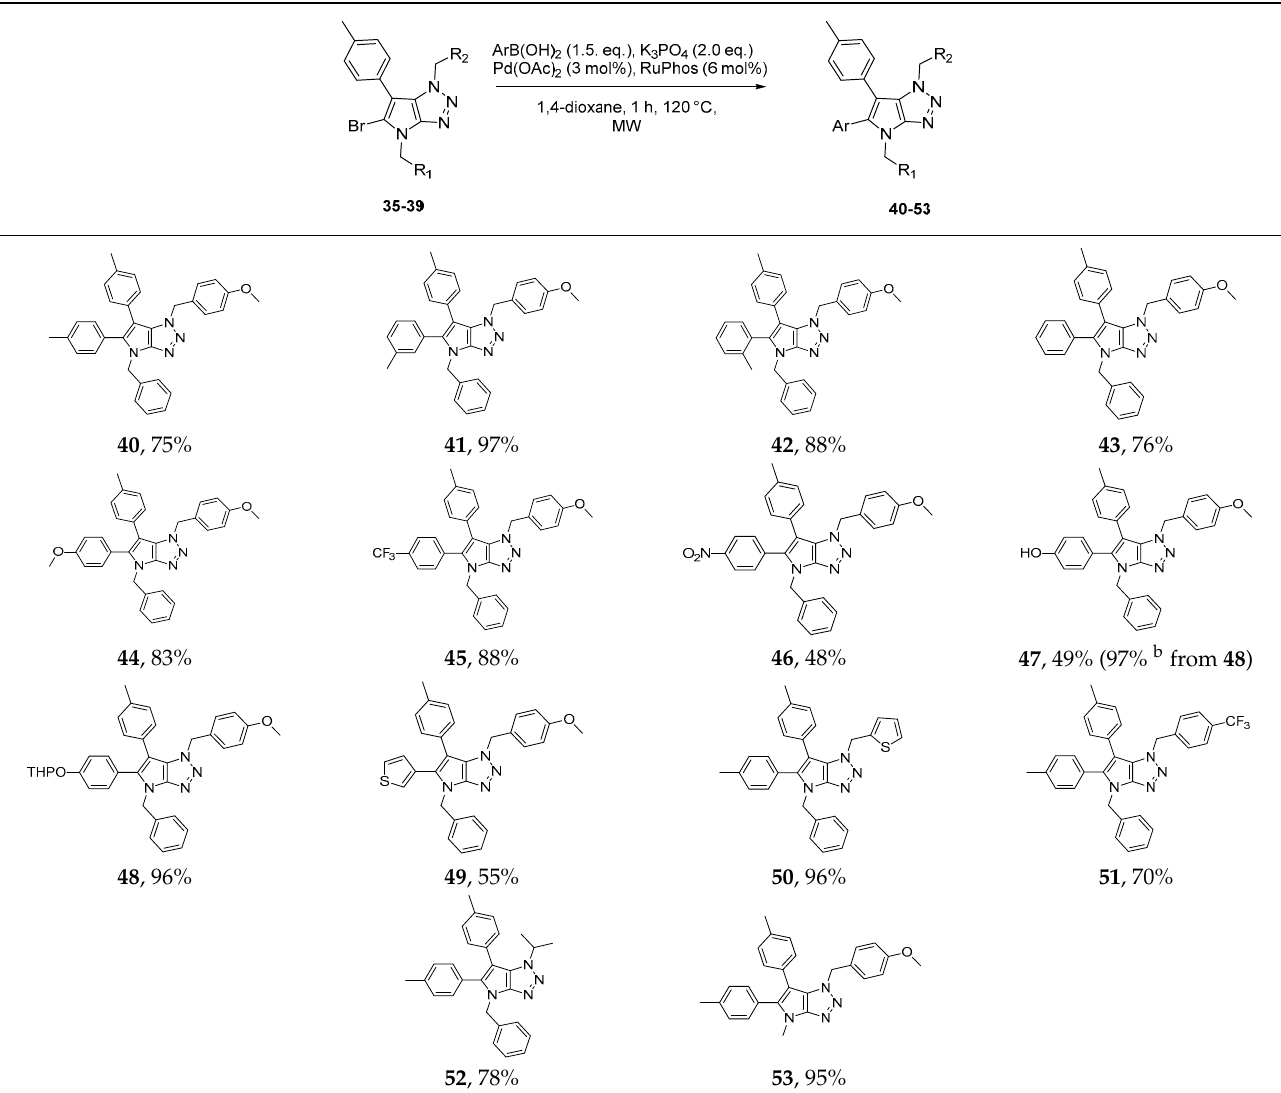
95% 95% 95% 95% 95% 95%